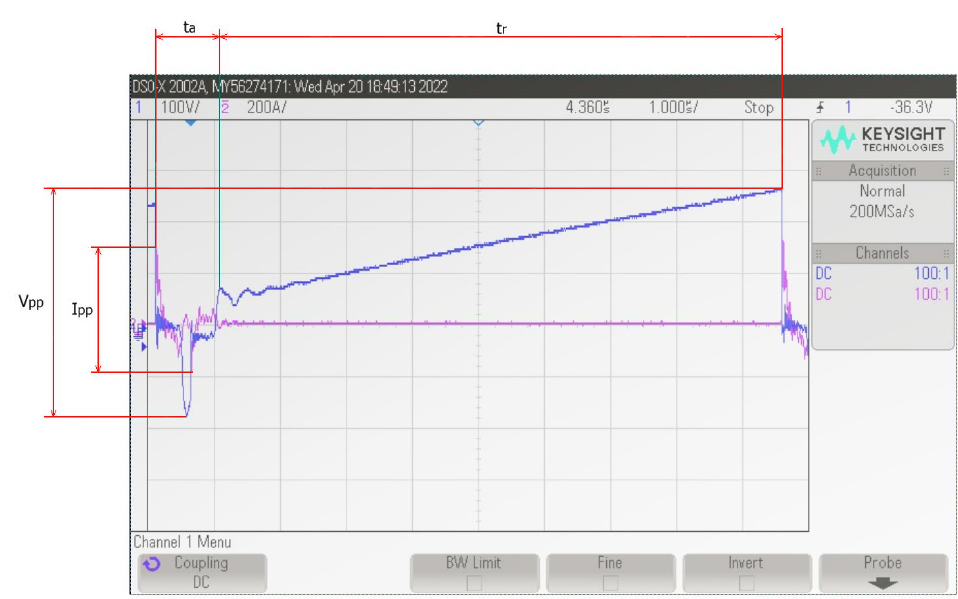
Figure 3. An example of one cycle of the EFT/burst (parameters: 100 V/div, 200 A/div, 1 us/div). One cycle was composed of time to ignition t i , burning arc t a and restoration t r